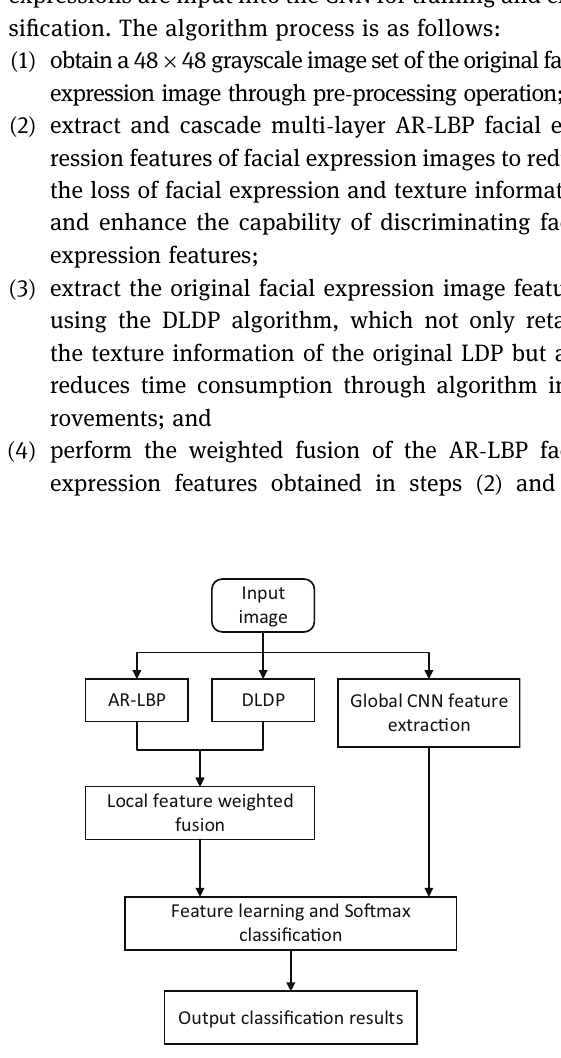
Figure 4: Flow chart of FER